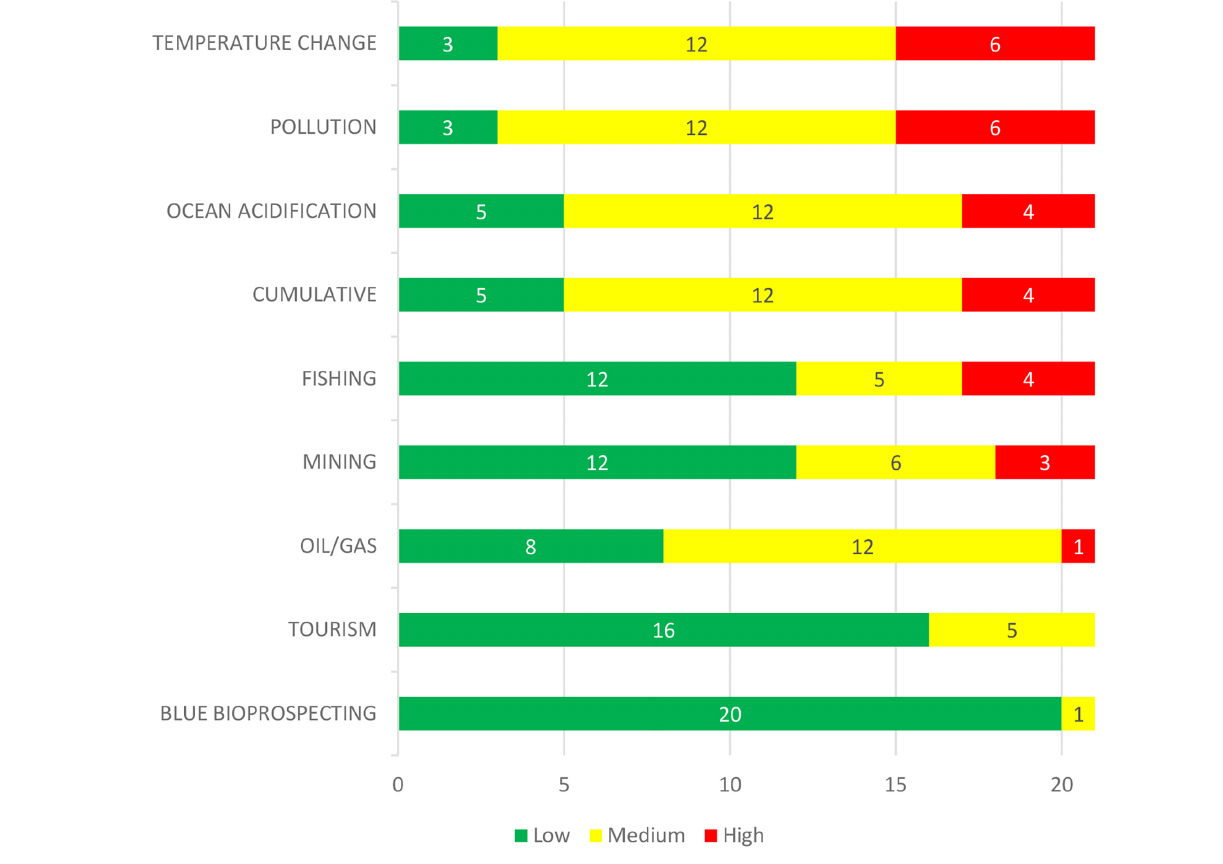
FIGURE 4 | Human drivers risk levels upon ecosystem services. From the assessment of negative effects of human drivers on ecosystem services. The x -axis represents the number of ecosystem services within each risk category (low, medium and